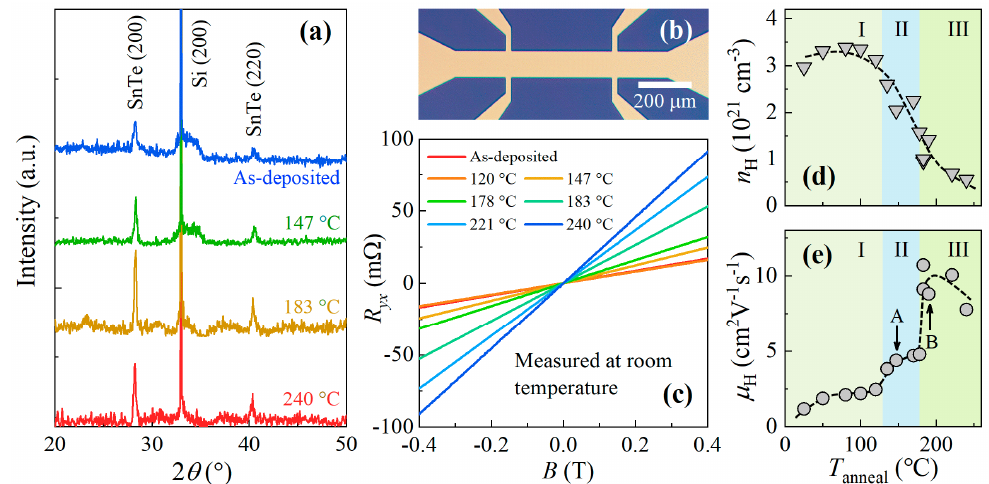
Figure 2. ( a ) X-ray diffraction patterns of 50-nm-thick SnTe films annealed at various temperatures. ( b ) Optical image of a typical Hall-bar device fabricated of sputtered SnTe film. The Hall-bar is 100 µ m in width, with a length-to-width ratio of 4:1. All transport data in this work were measured in Hall-bar devices with the same design. ( c ) Room-temperature Hall resistance of SnTe films. For clarity, only a few representative curves are shown. ( d , e ) Room-temperature Hall carrier density ( n H ) and Hall mobility ( µ H ) plotted as a function of annealing temperature. The dashed lines are a guide to the eye. The figures are divided into three regions according to the shape of the µ H ( T anneal ) curve. The arrows in ( e ) indicate the samples based on which devices A and B were fabricated.